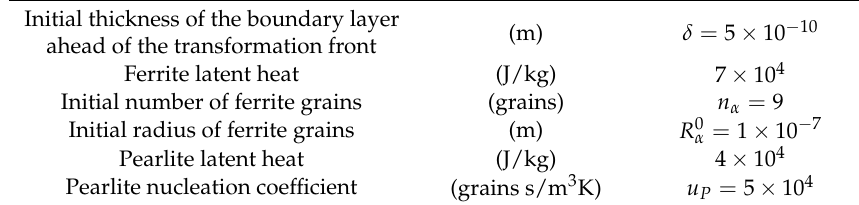
Table A3. Thermo-physical properties of SGI: solid-state phase change model.